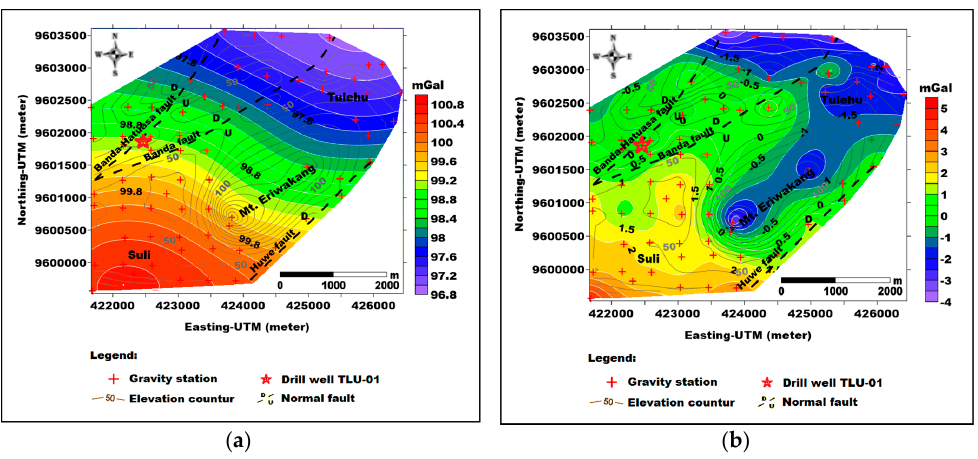
Figure 11. The anomalies separation using the upward continuation of 1 km on Suli and Tulehu geothermal areas ( a ) a regional anomaly; ( b ) a residual anomaly.